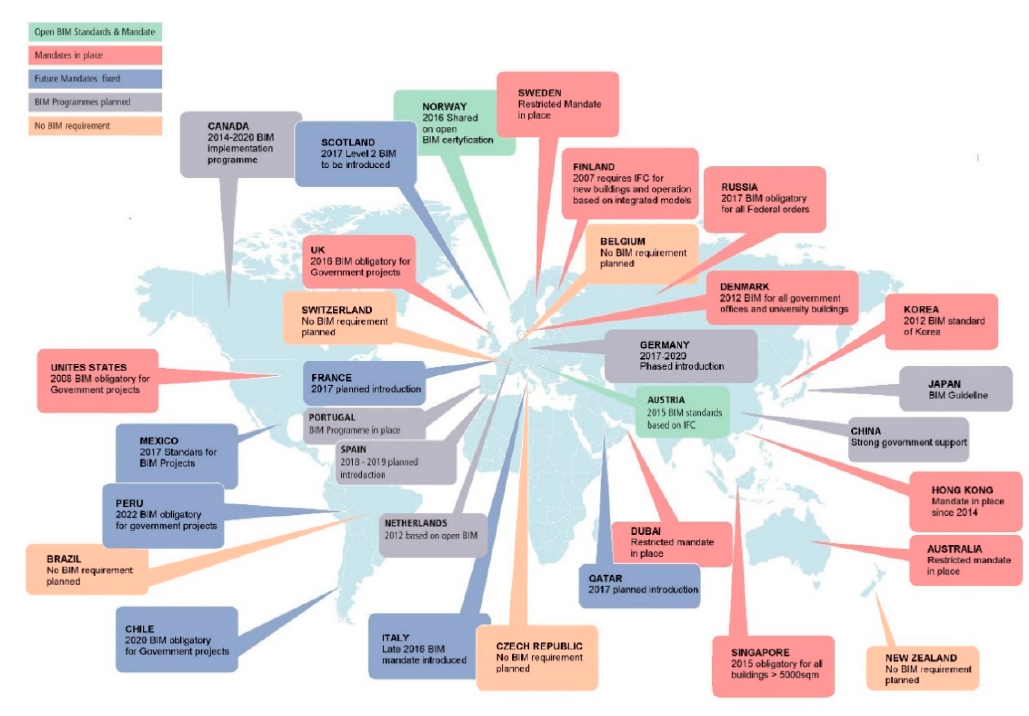
Figure 2. Overview of global BIM adoption [18].